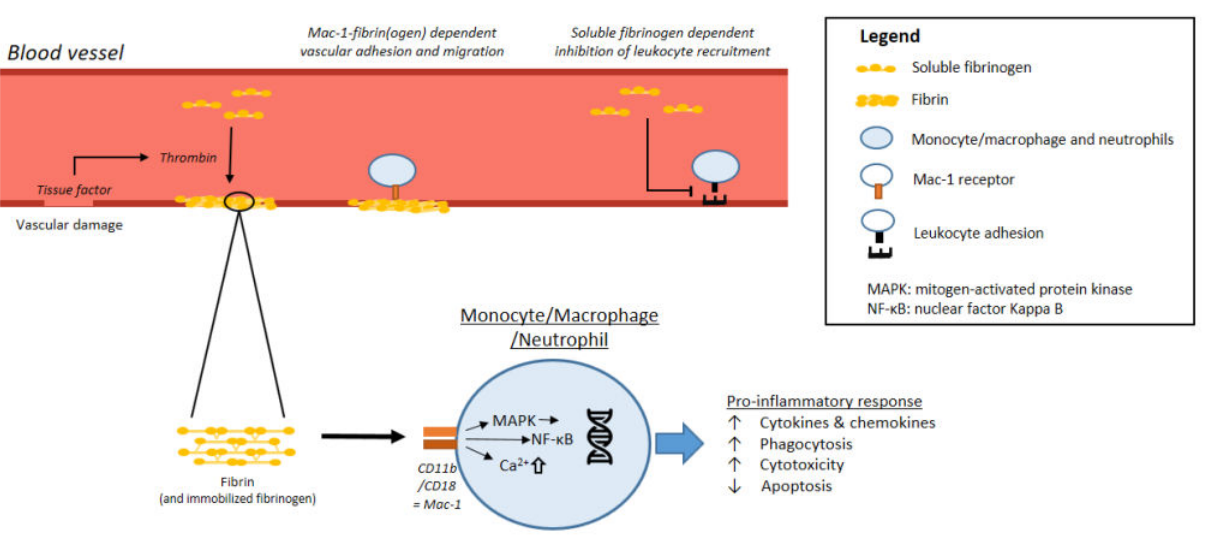
Figure 2. Fibrin(ogen)-immune system